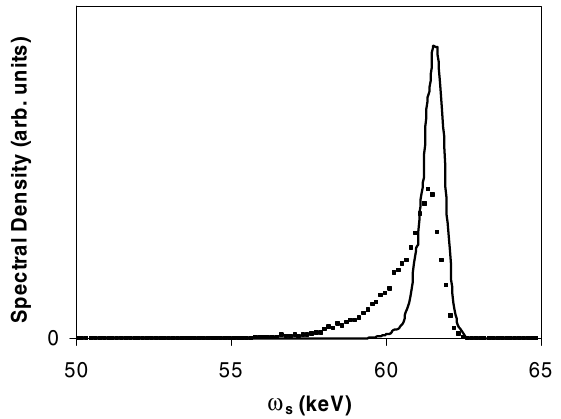
FIG. 10. (Color) False color plot of the spectral density of scattered x rays in the y - z plane resulting from the head-on (cid:2) 1 mm mrad collision of a 50 MeV electron bunch with " nx focused to an rms spot size of 20 (cid:18) m with an 800 nm, 0.5 ps bandwidth laser pulse polarized in the x direction.